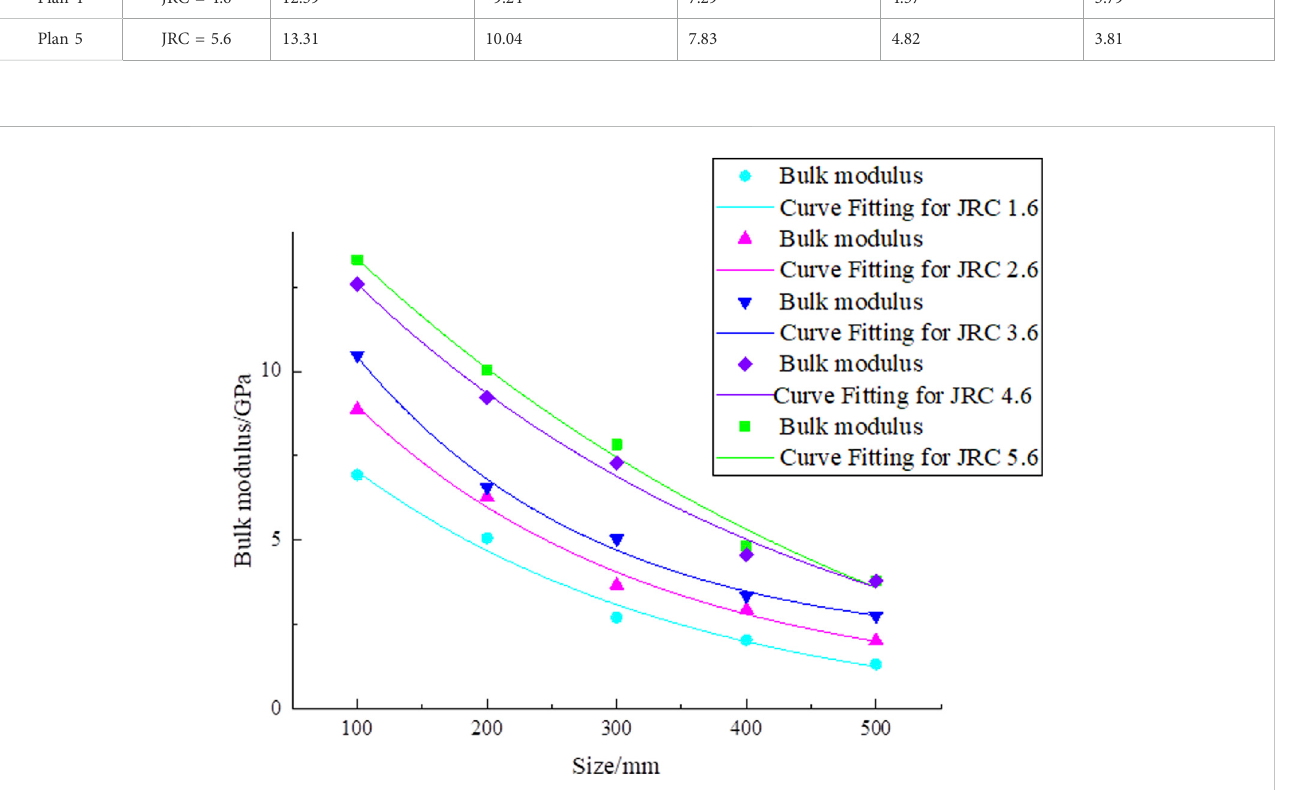
FIGURE 4 Fitting curves of rock size and bulk